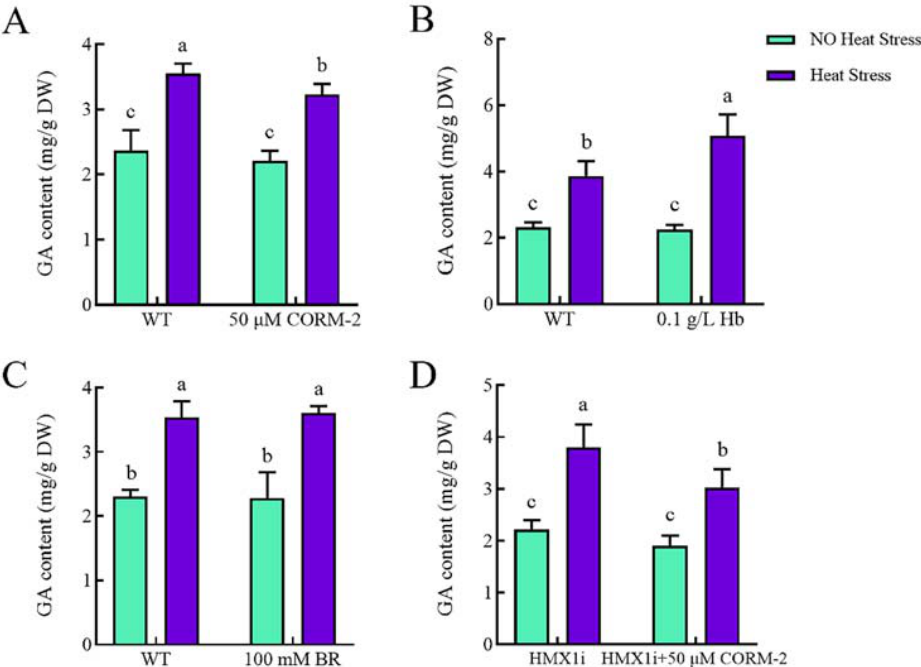
Figure 4. Effects of CO and BR on GA content under heat stress. Under heat stress, GA content would be significantly reduced or increased compared with the addition of the same dose of DMSO provided ( A ) 50 µ M CORM-2 or ( B ) 0.1 g/L Hb was added into WT strain, respectively. ( C ) The addition of 100 mM BR to WT strain would not affect GA content. ( D ) The addition of 50 µ M CORM-2 to HMX1 silenced strains diminished the GA content under heat stress. All calculated results are expressed as mean ± standard deviation, and these English letters of “a”, “b” and “c” are indicated significant differences among different treatments ( p < 0.05).